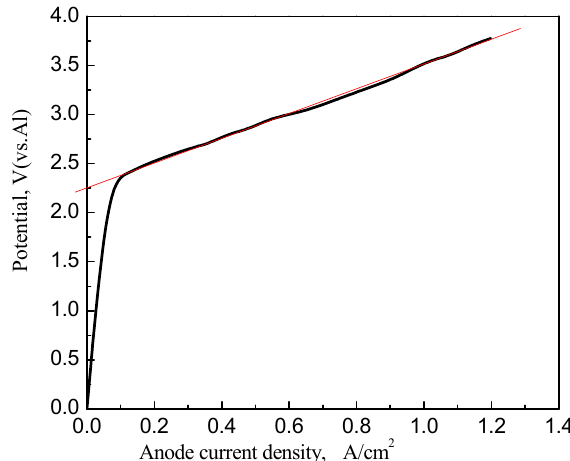
Figure 2. Plot of potential between reference electrode and inert anode at various current densities.